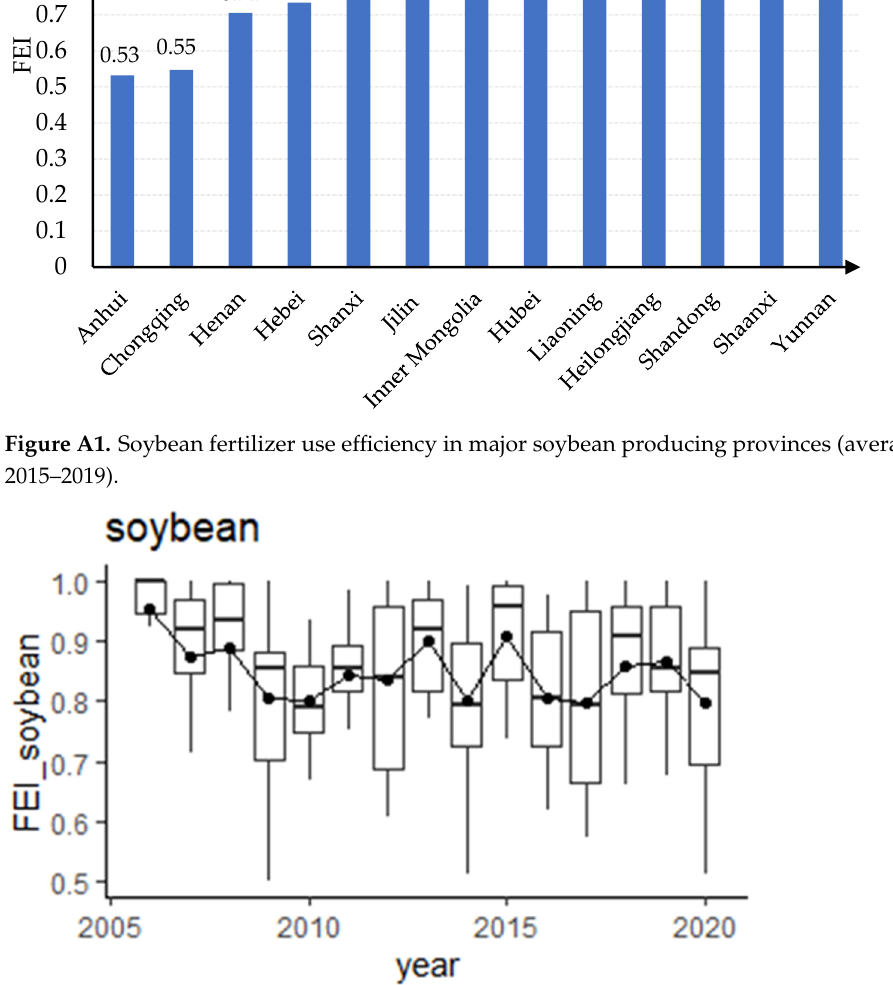
Figure A2. Trends in soybean fertilizer use efficiency.